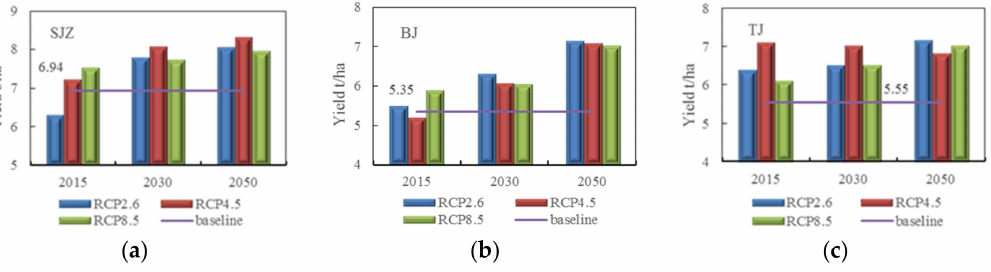
Figure 6. The yield of wheat in the different RCP scenarios. ( a – c ) are yield for Shijiazhuang, Beijing, and Tianjin, respectively.